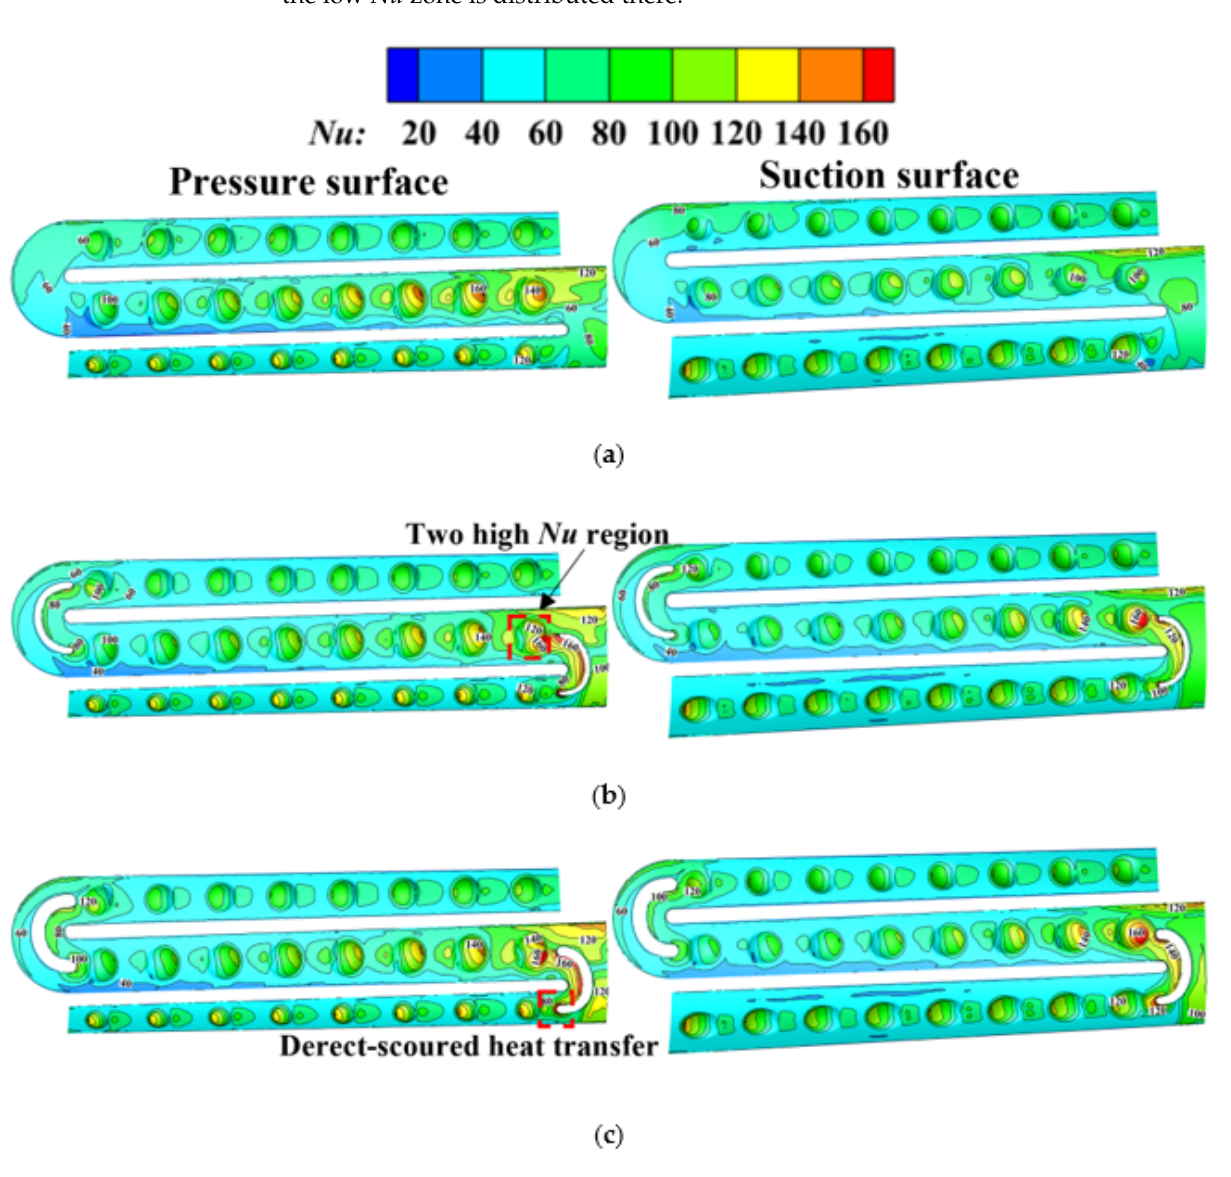
Figure 6. The Nu counters, Re = 10,000: ( a ) case1; ( b ) case3; ( c ) case5. In case3 and case5, the fluid enters pass2 in a uniform state due to the influence of the diversion and rectification of the turning vane. The nonuniformity between PS and SS is reduced. The fluid in the outer basin accelerates and impacts the side wall because of the cross-section contraction, which enhances the heat exchange in the first turning region. The inside wall of the turning vane is struck by the fluid to form a high Nu region. Then, the inner and outer fluids converge at the outlet of the first turning vane. Two high Nu